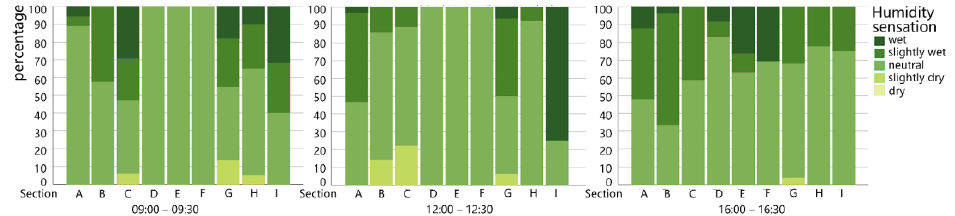
Figure A2. Air temperature sensation votes of the three time periods on 12 September.